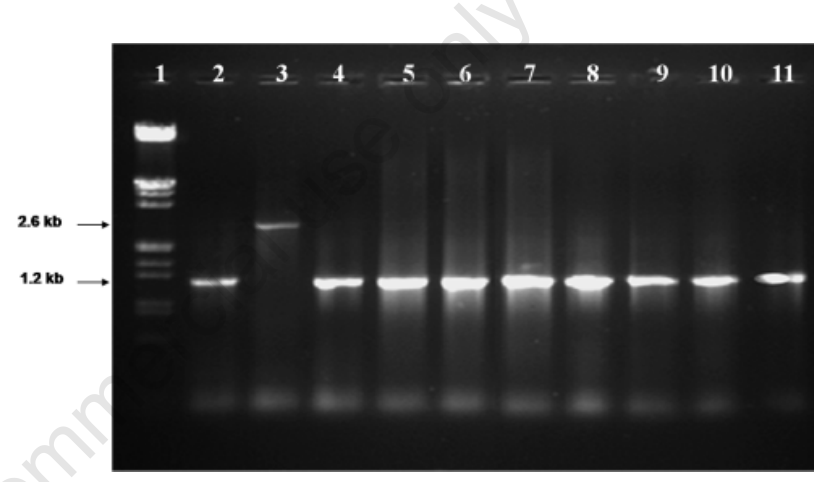
Figure 1. PCR of 10 representative clinical isolates of M. tuberculosis from Kerala using primers moa FP1and moa RP1. Lane 1: Marker DNA (DNA double digest ( Hind III / EcoR